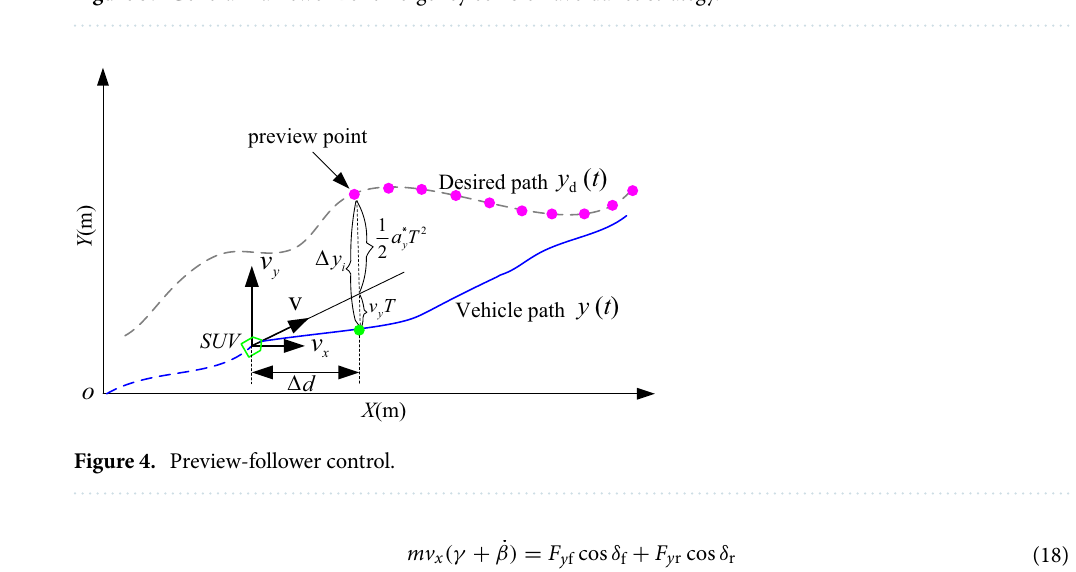
Figure 3. General framework of emergency collision avoidance strategy.